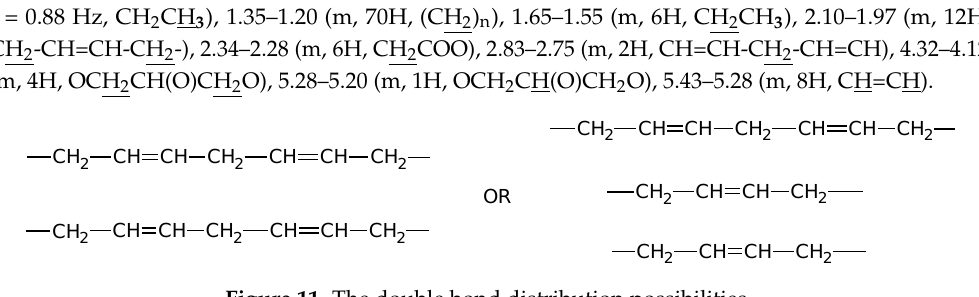
Figure 11. The double bond distribution possibilities.